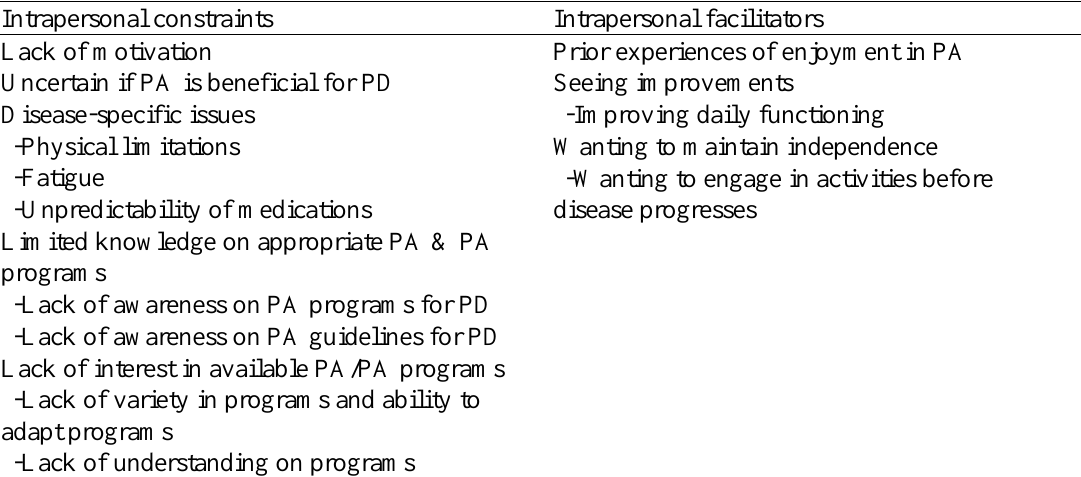
Table 2. Intrapersonal factors influencing PA behaviour for individuals with